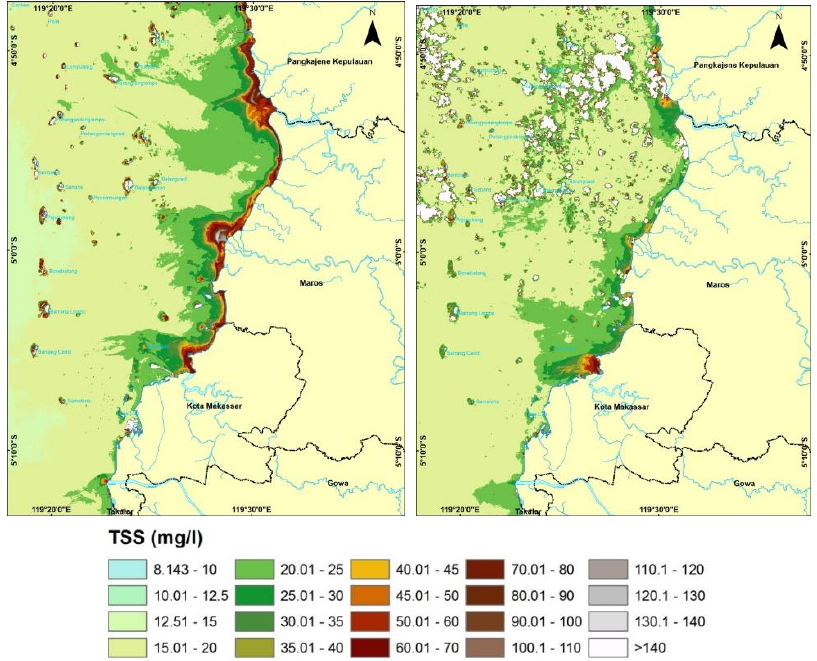
Figure 10. TSS distribution around Bontosua and Ballang Caddi island and near from the main land and shore lines in Spermonde waters in the western season December-February, (a) 2013, (b) 2016, (c) Years